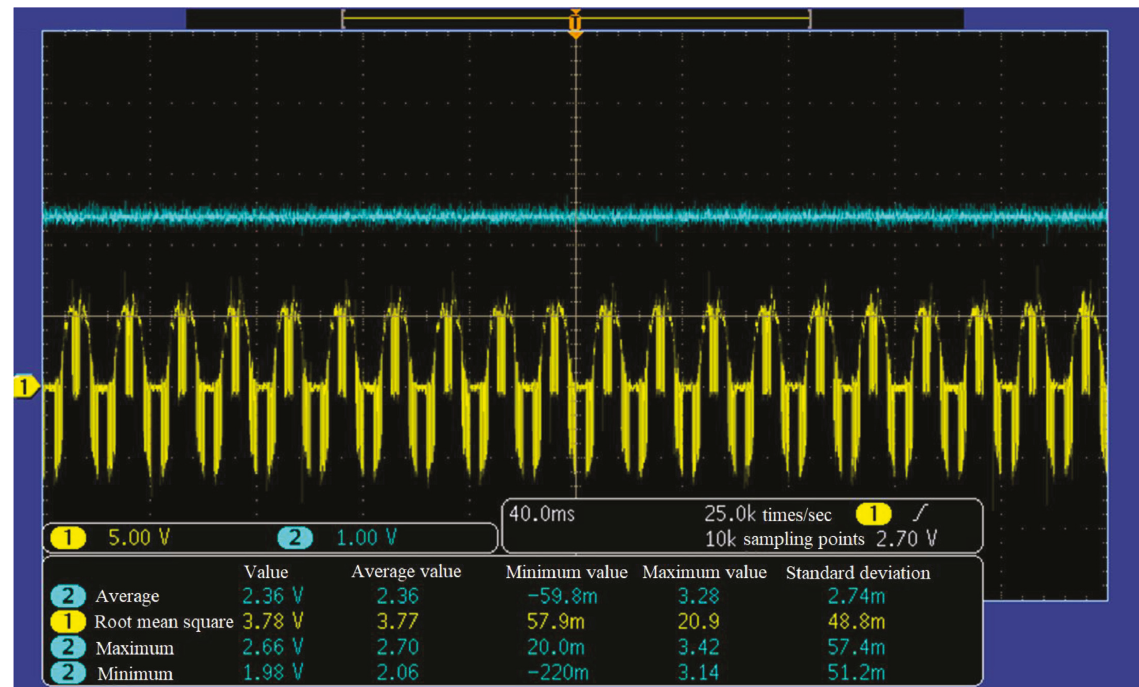
Figure 13: Preceding MR output voltage and voltage-regulator output voltage.